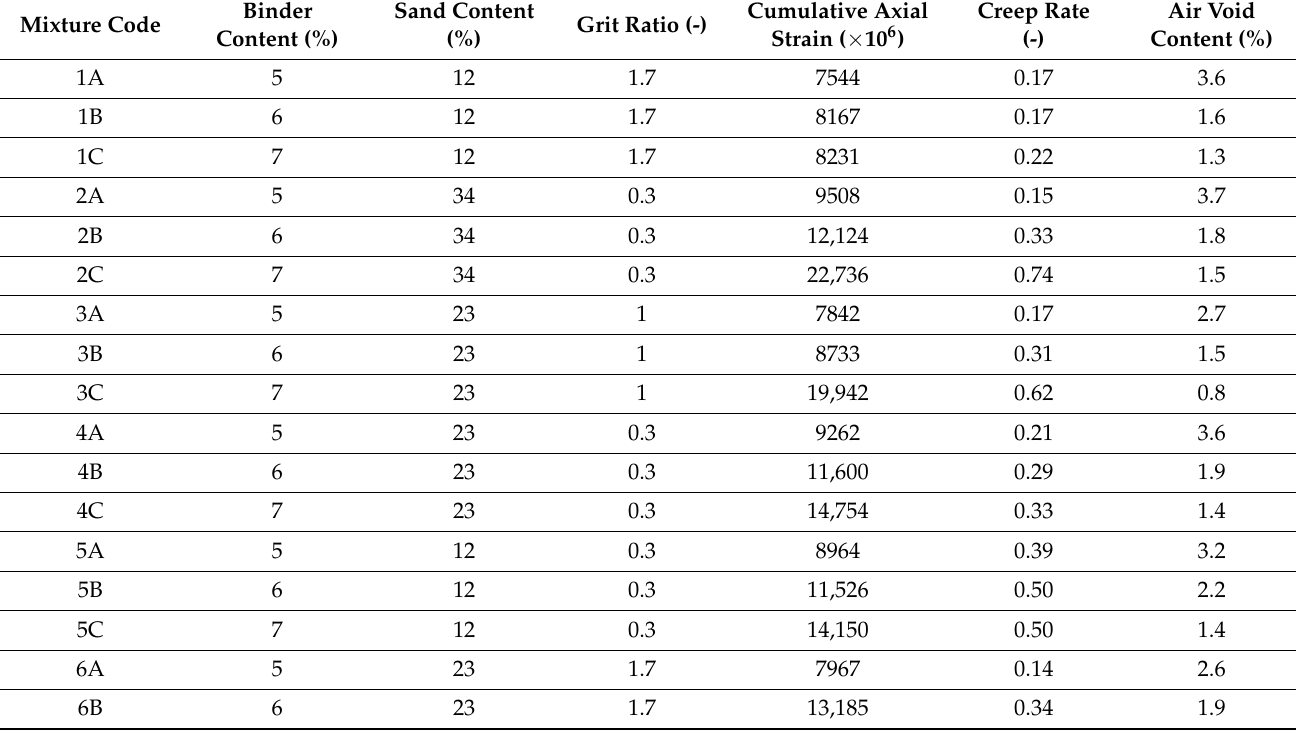
Table 1. Levels of variables in individual mixtures and their results of permanent deformation resistance test. Mixture